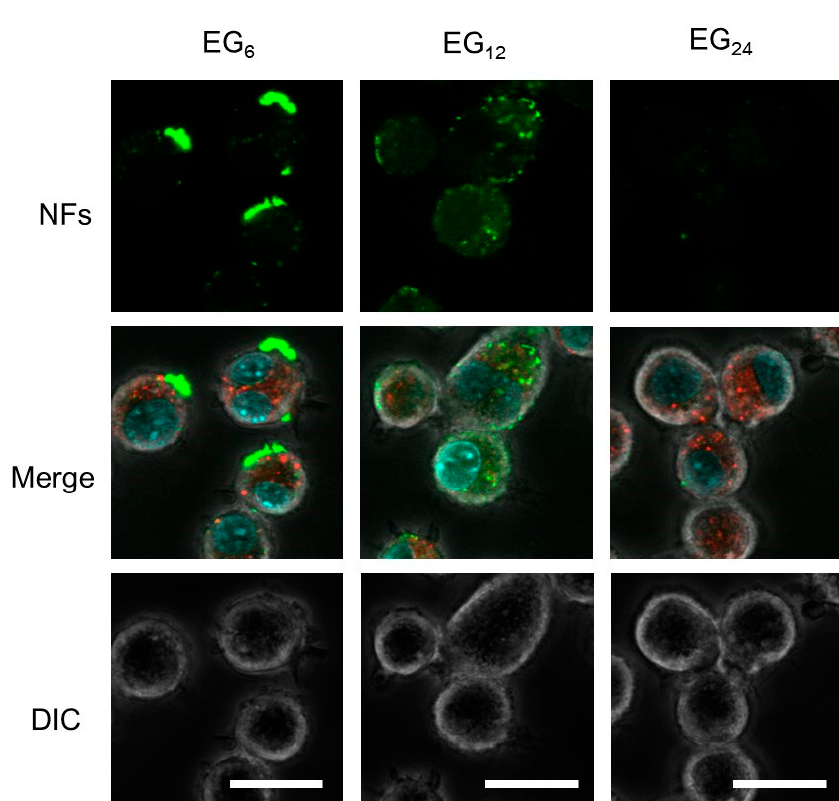
Figure 6. CLSM images of JAWS II cells treated with various EG n NFs labeled with fluorescein. JAWS II cells were incubated with EG n NFs at 37 °C for 2 h in serum-free medium. After incubation, the cells were treated with Lyso Tracker Red and Hoechst for staining intracellular acidic compartments and nuclei, respectively. Scale bars represent 20 μ